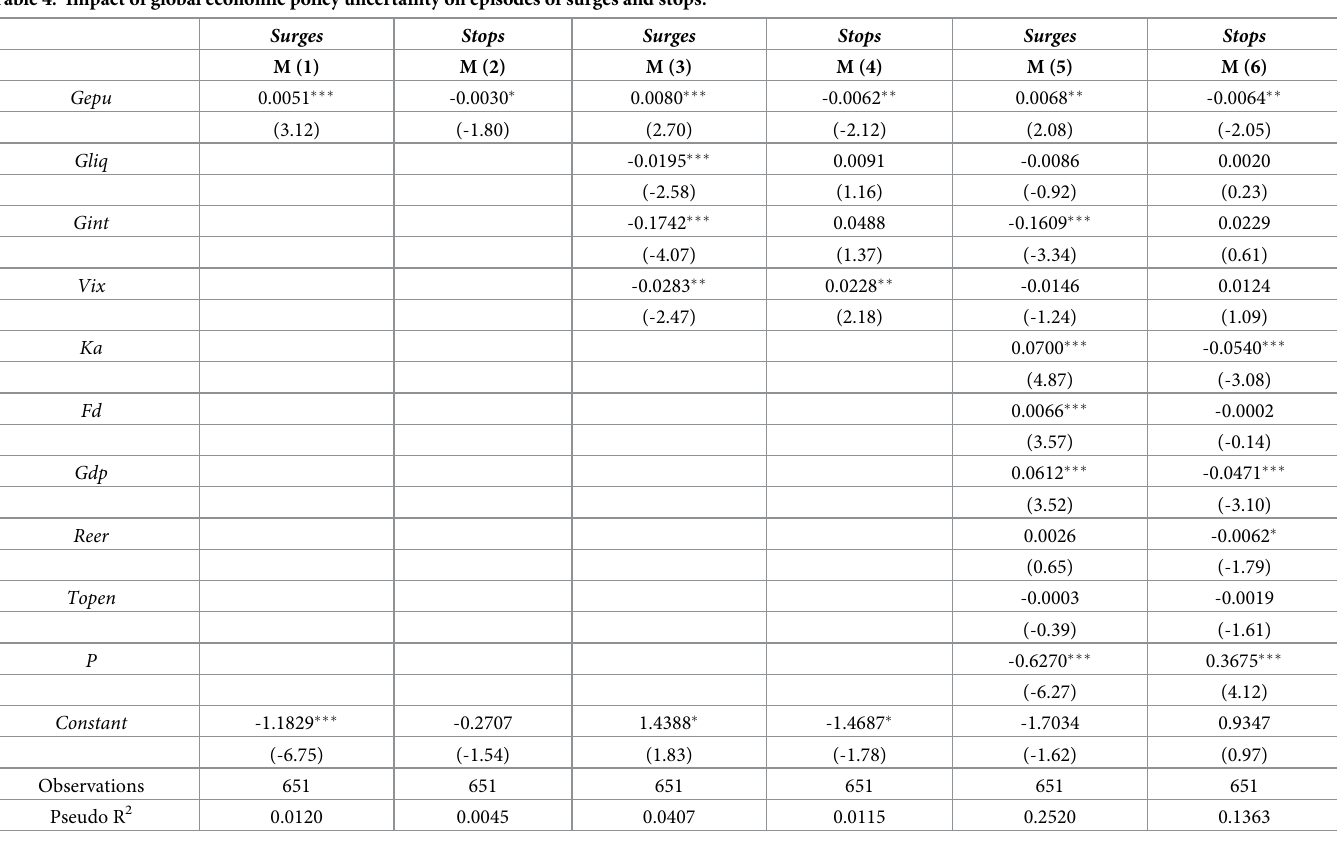
Table 4. Impact of global economic policy uncertainty on episodes of surges and